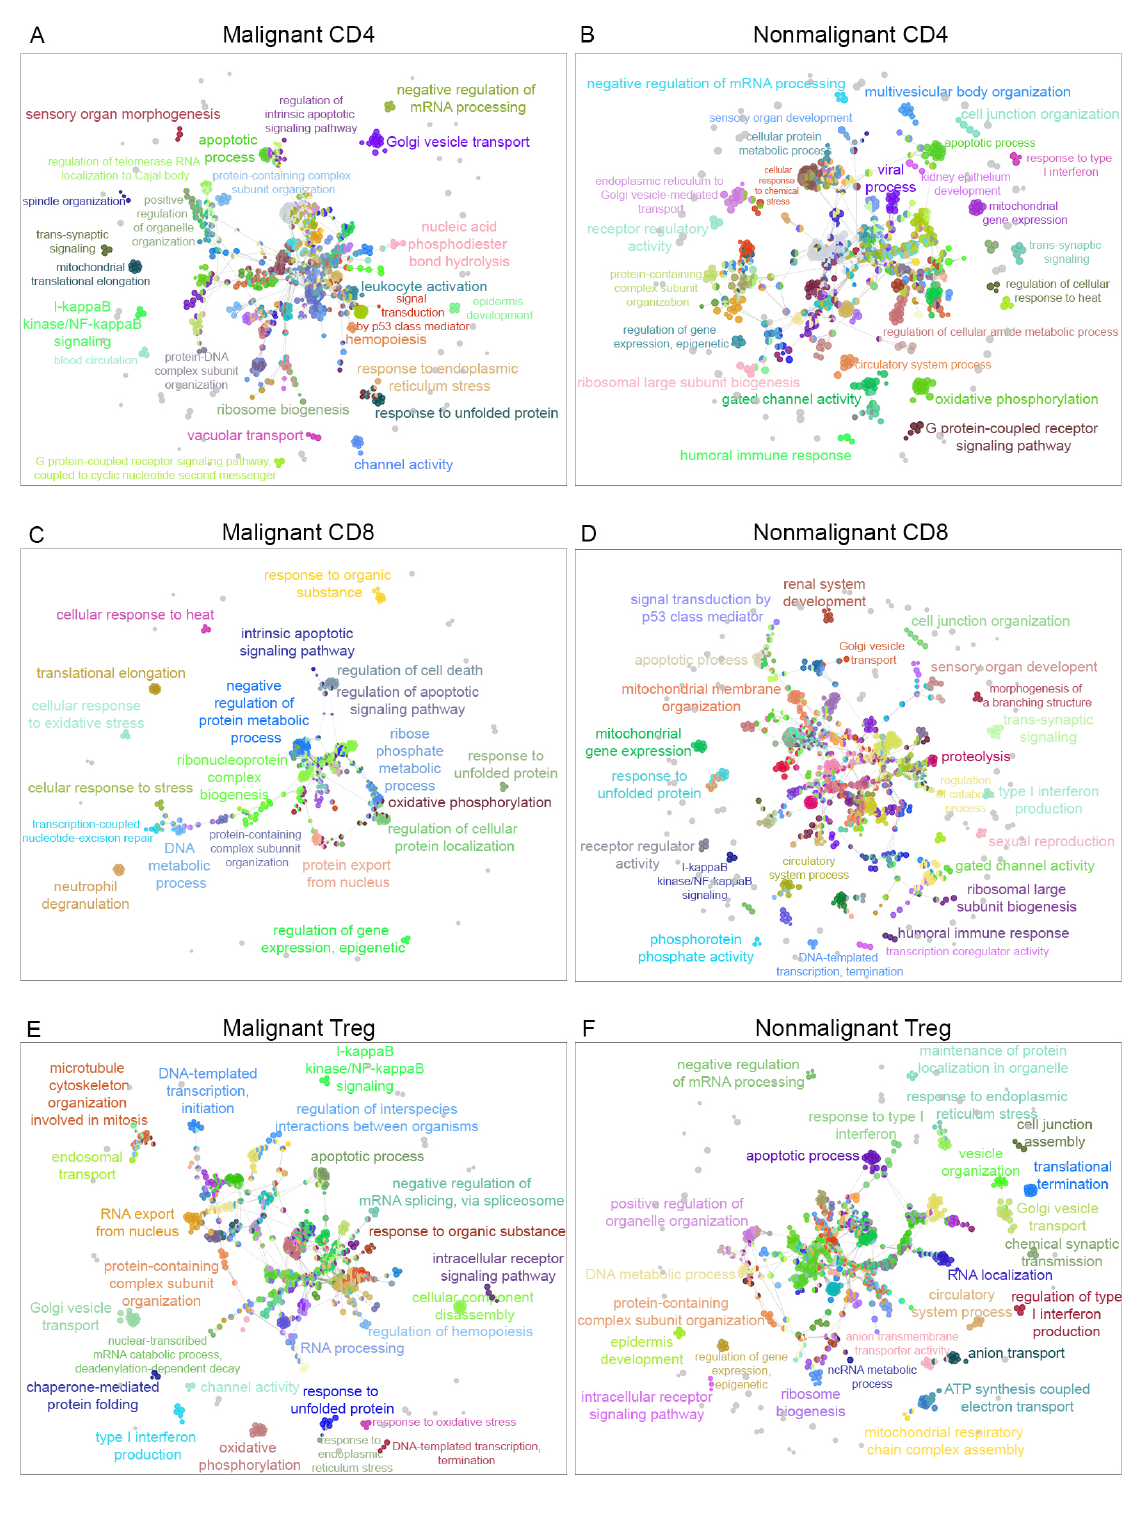
Figure 3. Gene ontology of biological processes networks. The visualization of the networks was performed in Cytoscape using the ClueGO plugin. ( A ) Network visualization of GO terms associated for CD4-T cells with malignant origin and ( B ) for GO terms associated with CD4-T cells from nonmalignant origin. ( C ) Network corresponding to GO terms of CD8-T cells from malignant origin and ( D ) network representing the GO terms associated with CD8-T cells with nonmalignant origin. ( E ) GO terms associated with Treg cells from malignant origin and ( F ) GO terms associated with Treg cells from nonmalignant